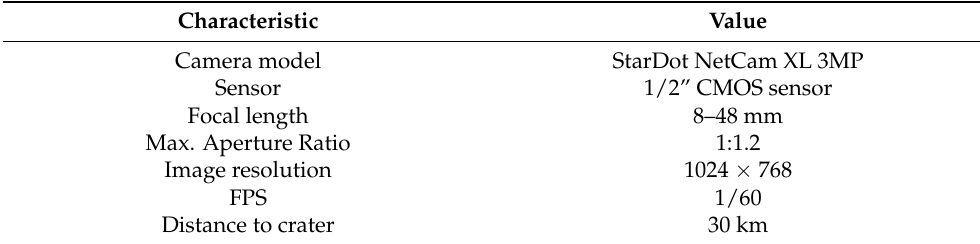
Table 2. Main specification of the video camera, considered in the current